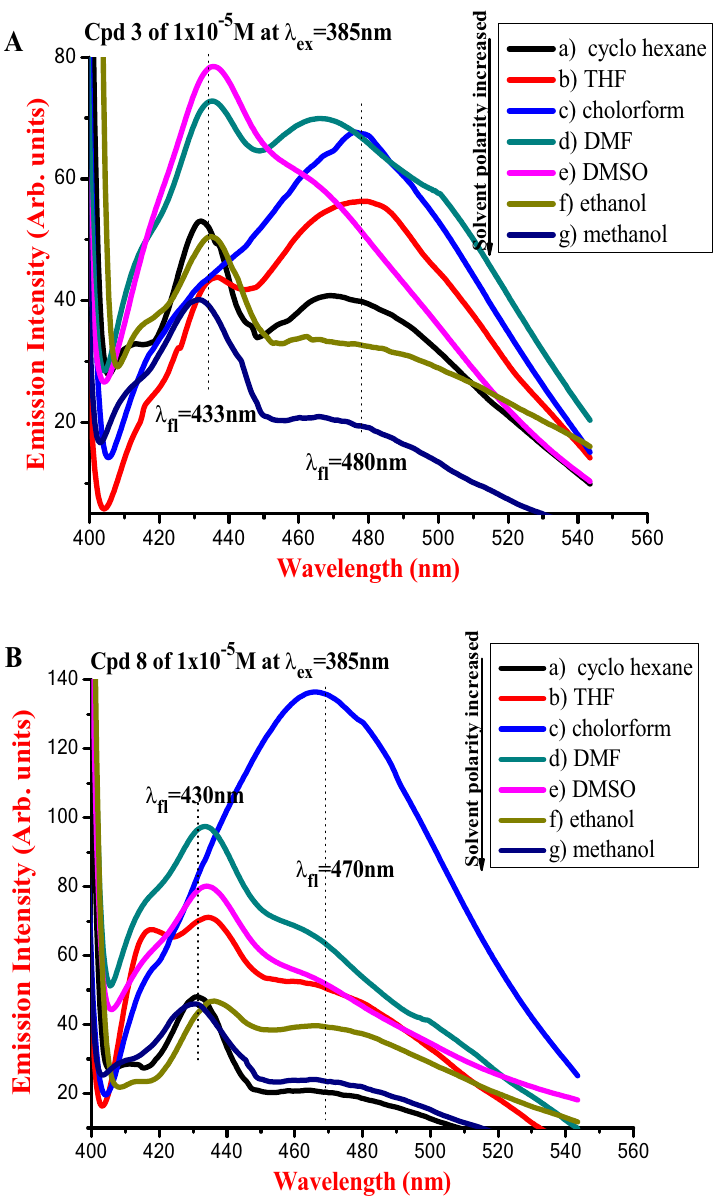
Figure 13. ( A , B ) Emission spectra of [1 × 10 −5 M] of compounds (a) 3 , (b) 5 of exciting wavelength (385 nm) in different